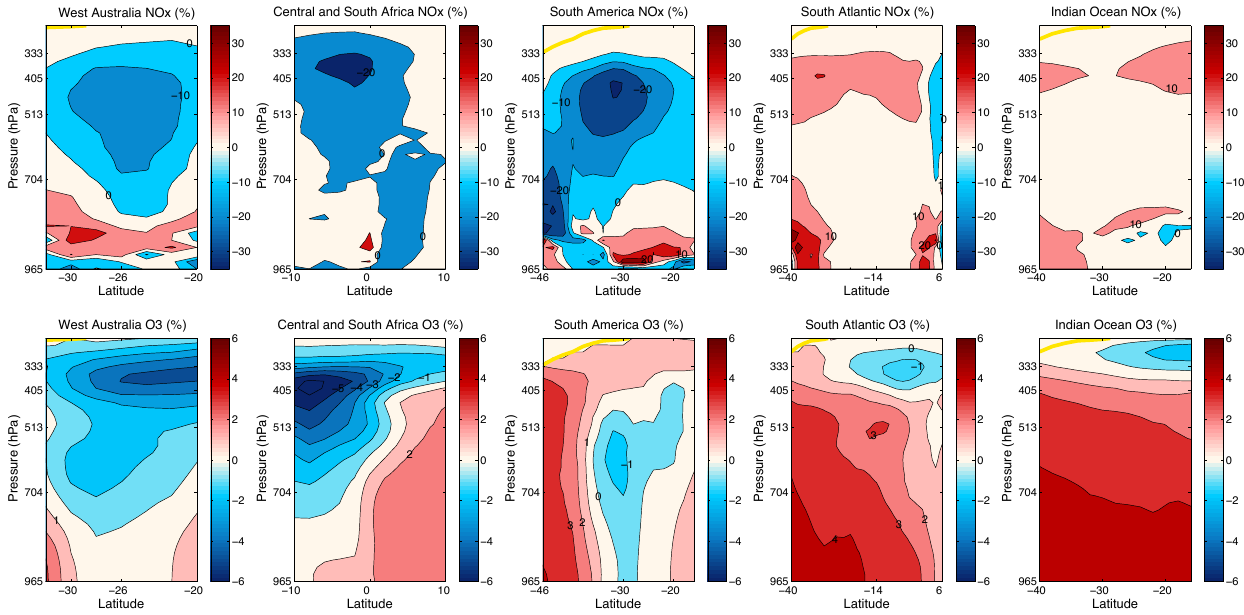
Figure 6. Zonal averaged NO x (upper panels) and O 3 (bottom panels) variations (in %) over the regions characterized by strong NO x emissions for January (the yellow solid line represents the tropopause level) from the relative difference between P1 and BC experiments (P3/BC). P1 was performed using τ and K eff determined with D h = 15m 2 s − 1 and NO mean